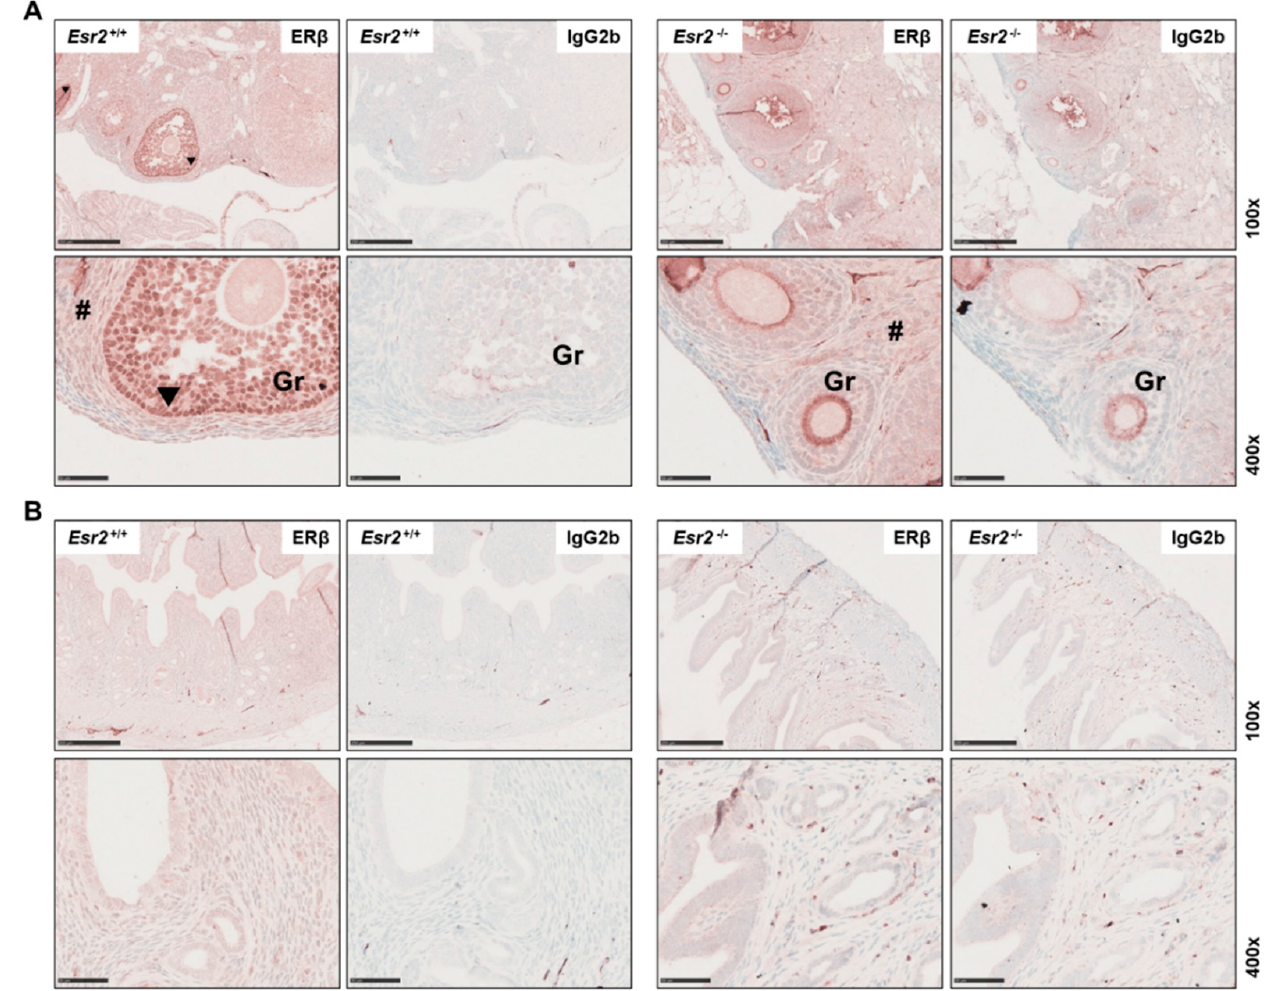
Figure 3. Female reproductive tissues of Esr2 -depleted mice are negative for estrogen receptor beta (ER β ) expression. Ovaries ( A ) and uterine tissue ( B ) of Esr2 knockout ( Esr2 − / − ) and wild-type ( Esr2 +/+ ) animals from the same mouse line were stained with PPZ0506 antibody or with isotype-specific IgG 2b negative control. Only granulosa cells (Gr) in Esr2 +/+ ovaries strongly express ER β , whereas in Esr2 − / − ovary and uterine tissue no specific nuclear staining was observed. Specific staining is shown by arrowheads in Esr2 +/+ and # indicates diffuse non-specific background staining. Scale bar 250 µm (100×) or 50 µm (400×).